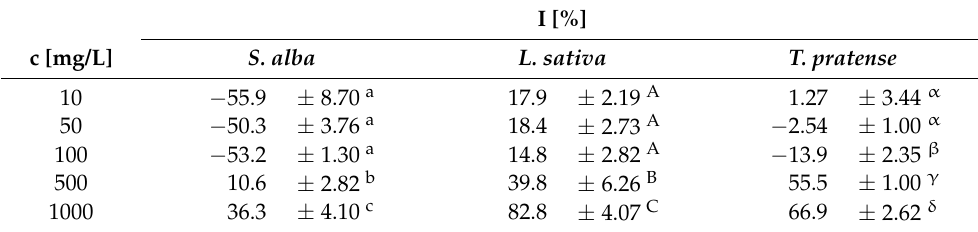
Table 4. The inhibition of root elongation (calculated as a percentual inhibition of root growth compared to control) of white mustard ( Sinapis alba ), lettuce ( Lactuca sativa ) and clover ( Trifolium pratense ) after 3 days of seed germination in a solution supplemented with B 2 O 3 at concentrations of 10, 50, 100, 250, 500 and 1000 mg/L. Standard deviation is represented as ± S.D. ( n = 3), and two-way ANOVA test with Dunnett’s multiple comparisons was